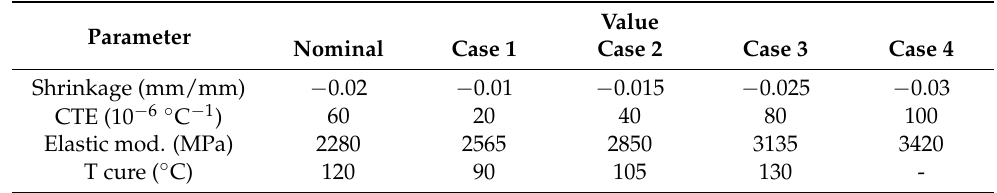
Table 5. Set of parameters used in the sensitivity analysis.